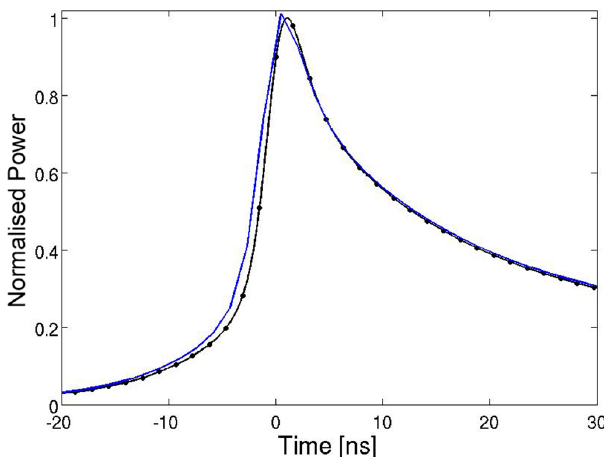
= 8dB and a snow Figure 14. Simulated waveform for σ 0 surf-ice depth of 30cm. The simulated waveform is shown in black and the sub-sampled points at the sampling resolution of CryoSat-2 are rep- resented by the black dots. The blue line shows the best-fit wave- form, which assumes backscattered power originates from the sea ice interface